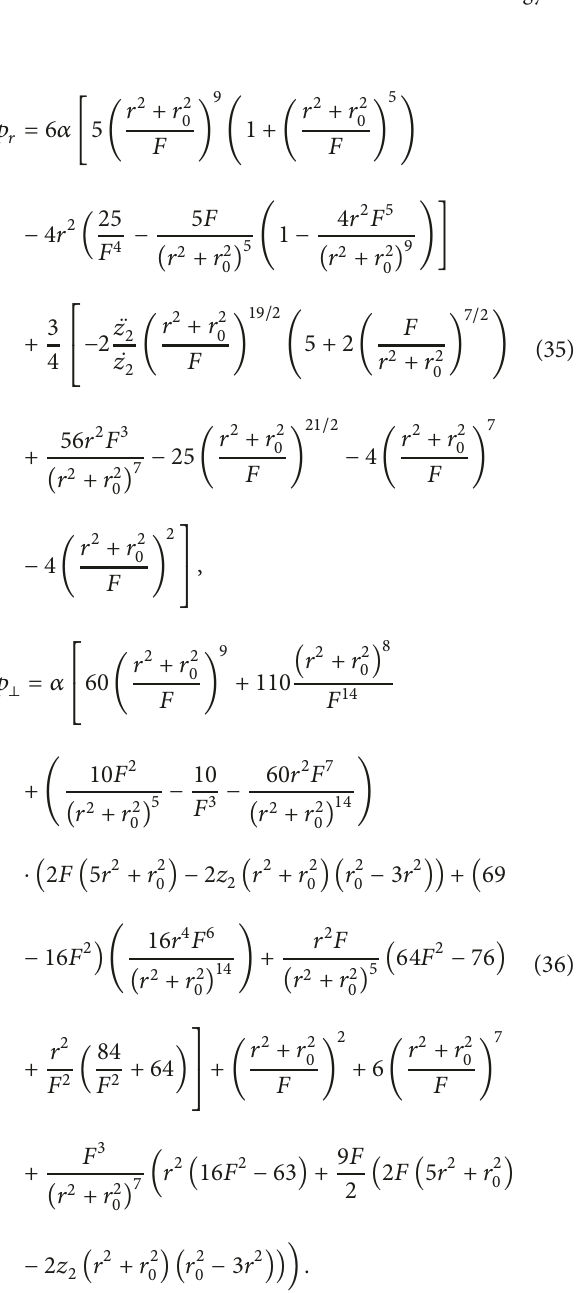
Figure 6: Plot of energy conditions along 𝑟 and 𝑡 for 𝑘 = 2.5